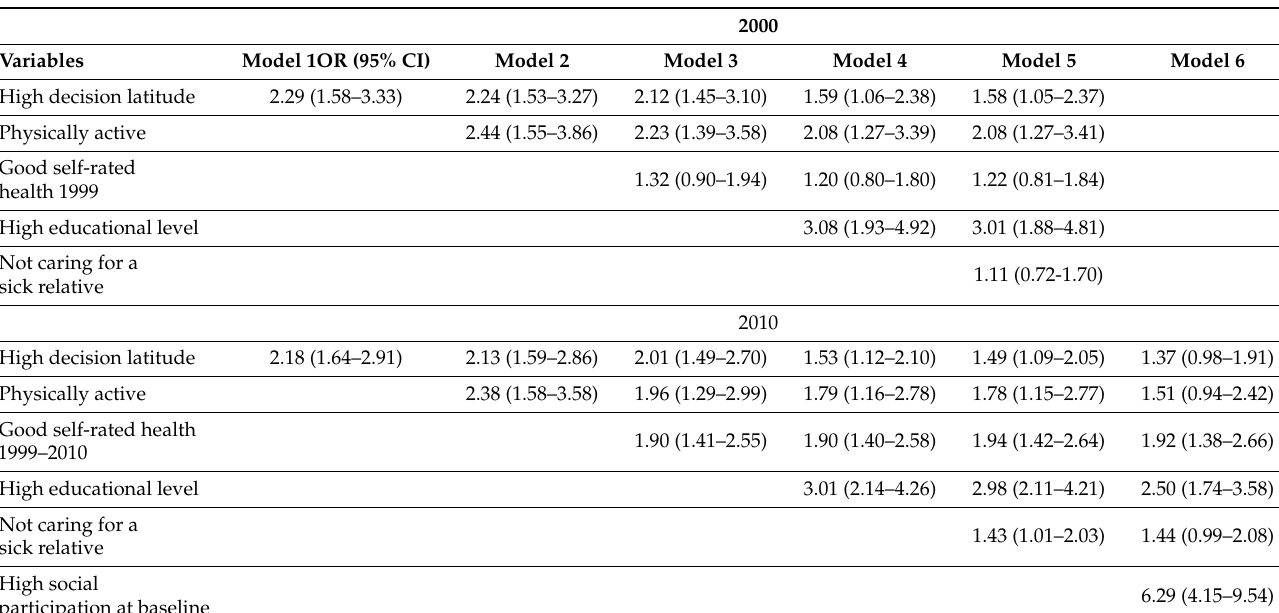
Table 4. Associations between high decision latitude at baseline, as defined by the demand-control model, and high social participation at baseline and at the 10-year follow up, respectively ( n =